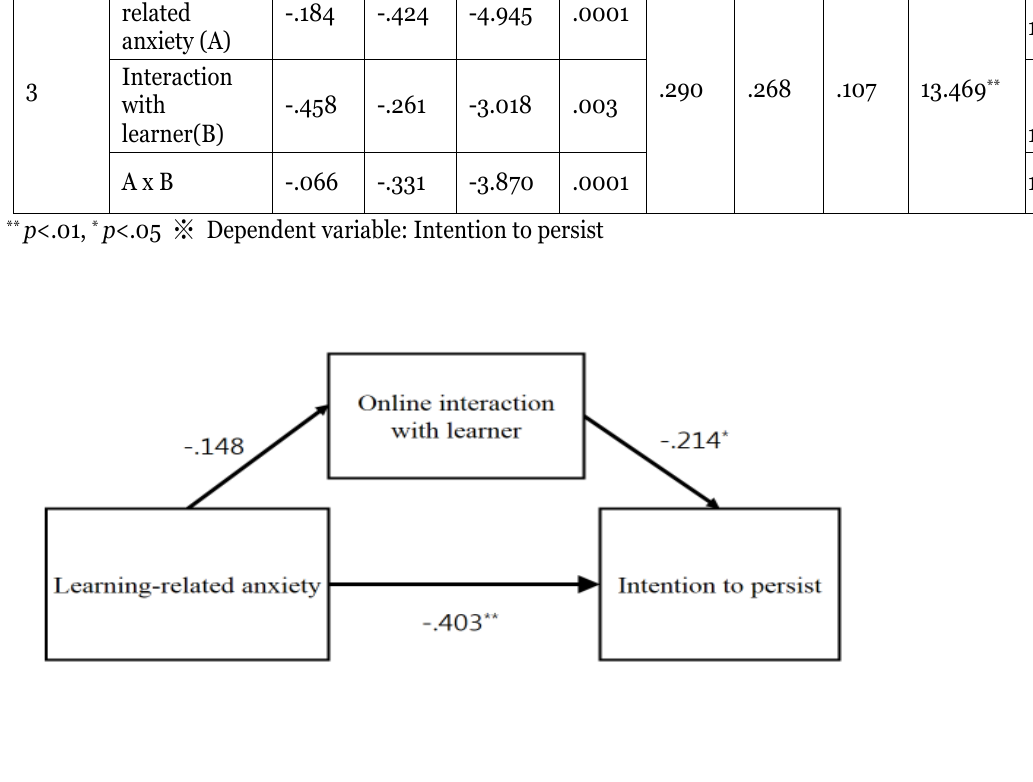
Figure 2. The suppressor role of interaction with